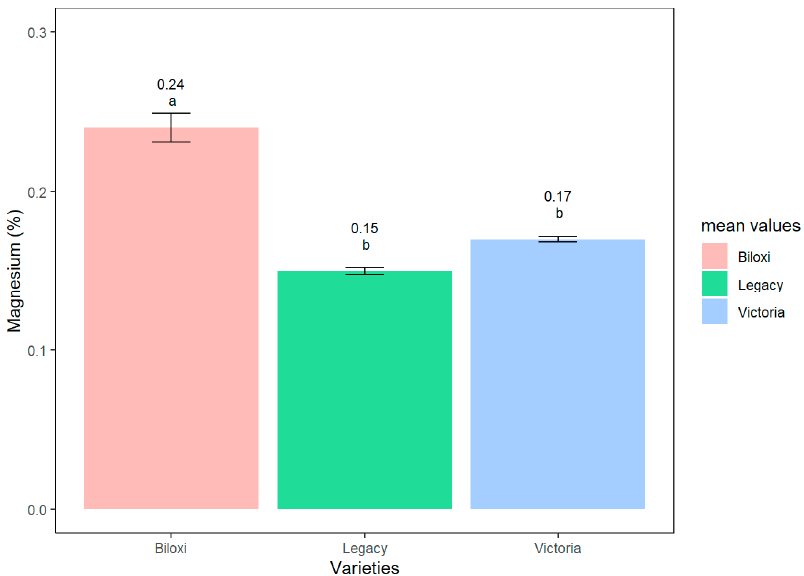
Figure 6. Comparison of the foliar Magnesium content in Biloxi, Legacy and Victoria variety blueberry plants. Different letters indicate significant differences ( p < 0.05) according to the Tukey’s multiple comparison test of means. Vertical bars in each average indicate the standard error (n = 30).